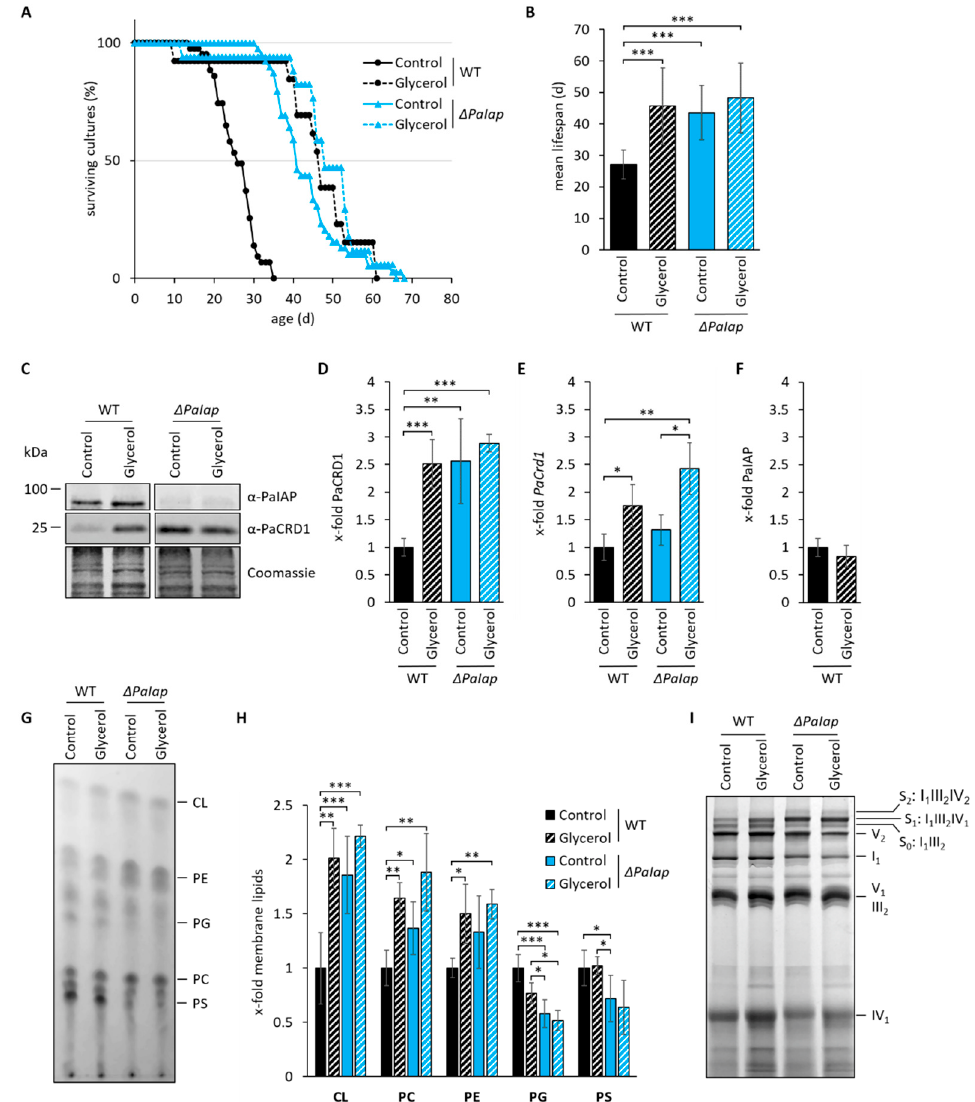
Figure 6. Absence of PaIAP alters mitochondrial protein and PL composition comparable to those observed in respiratory active mitochondria. ( A ): Lifespan analysis of wild type (WT) and Δ PaIap grown on M2 either with dextrin (control, glycolytic condition) or glycerol (respiratory condition) as primary carbon source at 27 °C. ( B ): Mean lifespan from ( A ). Data represent mean ± SD (wild type (control): n = 43; wild type (glycerol): n = 13; Δ PaIap (control): n = 39; Δ PaIap (glycerol): n = 17). ( C ): Western blot analysis of isolated mitochondria of 7-day-old WT and Δ PaIap grown on CM medium with either glucose (control) or glycerol as primary carbon source. Coomassie staining was used as loading control. ( D ): Quantification of PaCRD1 in ( C ). PaCRD1 levels were determined and related to wild type (set to 1). Data represent mean ± SD (control: n = 5; glycerol n = 3). ( E ): PaCrd1 transcript analysis of 5-day-old wild type and Δ PaIap grown on M2 medium either with dextrin (control) or glycerol. PaCrd1 transcript level was analyzed by RT-qPCR and normalized to PaPorin expression level. Data represent mean ± SD (wild type (control): n = 6; Δ PaIap (control): n = 3; glycerol: n = 3). ( F ): Quantification of PaIAP in ( C ). PaIAP levels were determined and related to wild type (set to 1). Data represent mean ± SD (n = 3). ( G ): One-dimensional TLC analysis of mitochondrial PLs of the wild type (WT) and Δ PaIap grown on glucose (control) or glycerol containing CM medium. PL extraction and analysis was performed as described in Material and Methods . ( H ): Quantification of PL spots in ( G ). Intensity of each PL spot was measured and related to the intensity of the whole